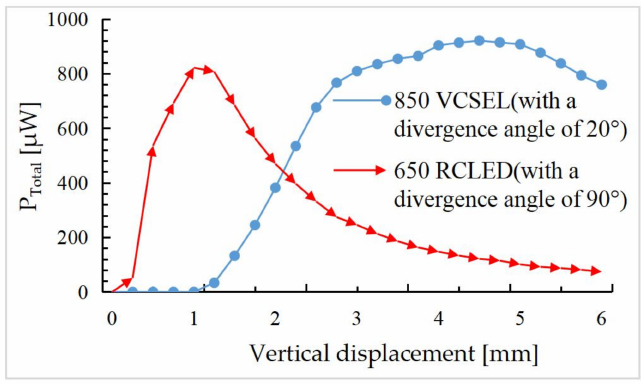
Figure 10. The total received light power versus the vertical position of the mirror plate.